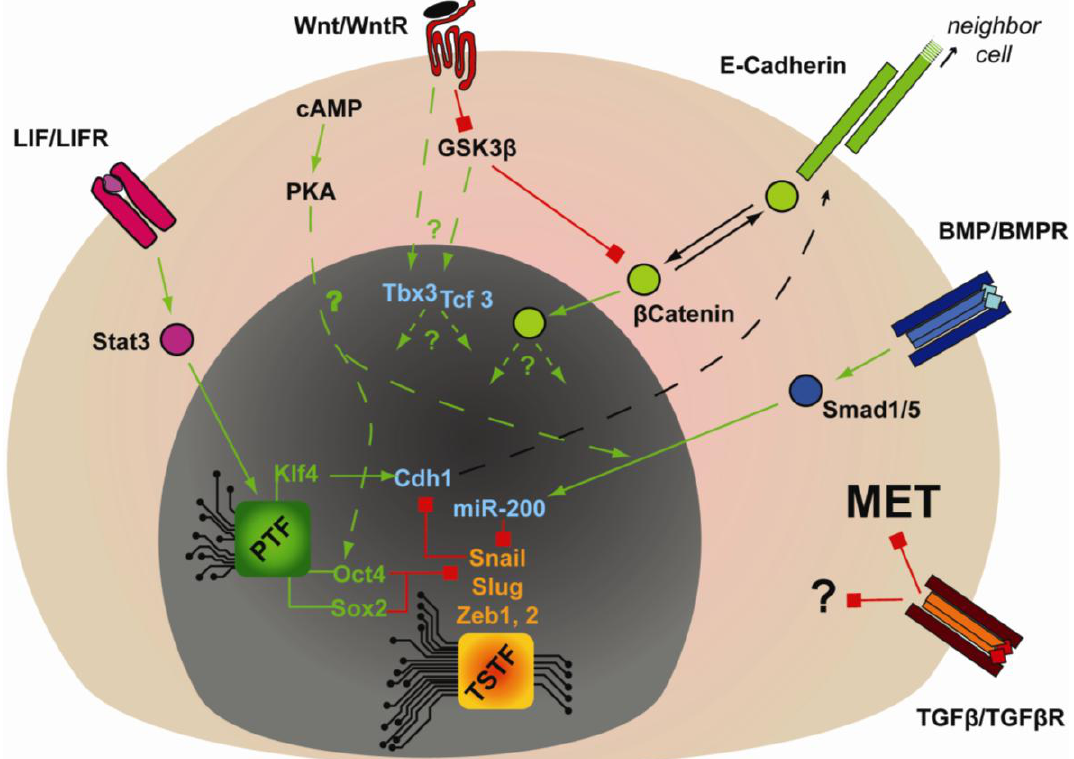
Figure 3. Pathways regulating the acquisition of pluripotency. MET: mesenchymal to epithelial transition, PTF: Pluripotency associated Transcription Factors, TSTF: Tissue Specific Transcription